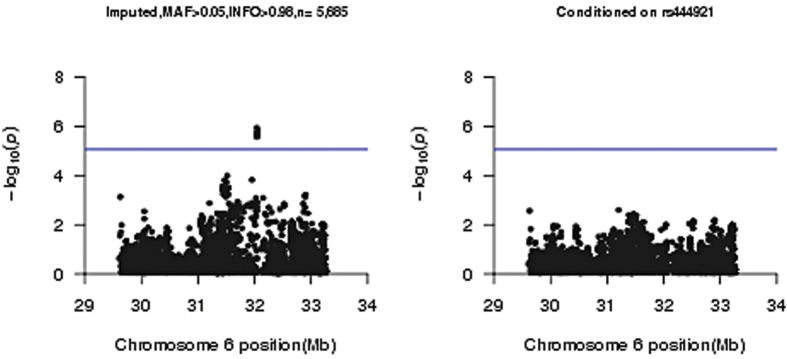
Plots of −log10 p-values for association for HLA-region genotyped SNPs and imputed SNPs, (a) For the fully adjusted model using all imputed SNPs, (b) same as (a) conditioning on top SNP rs444921.